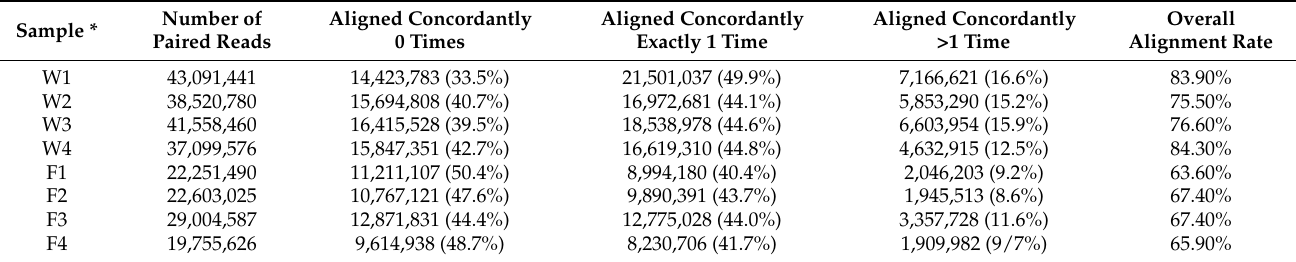
Table 1. Summary statistics of sequence alignment process.